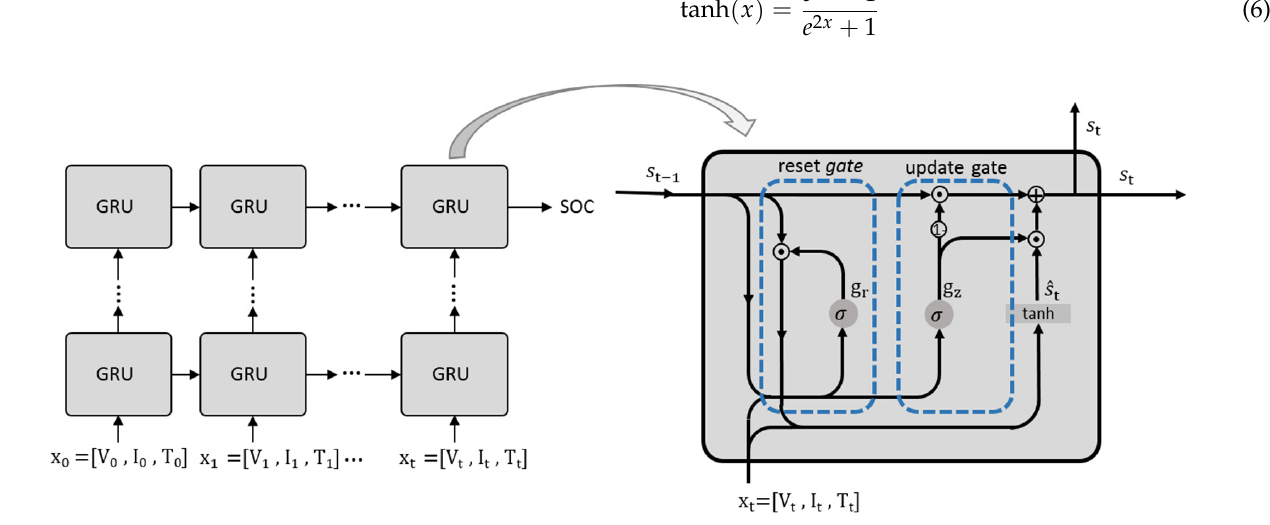
Figure 1. Structure of gated recurrent unit.